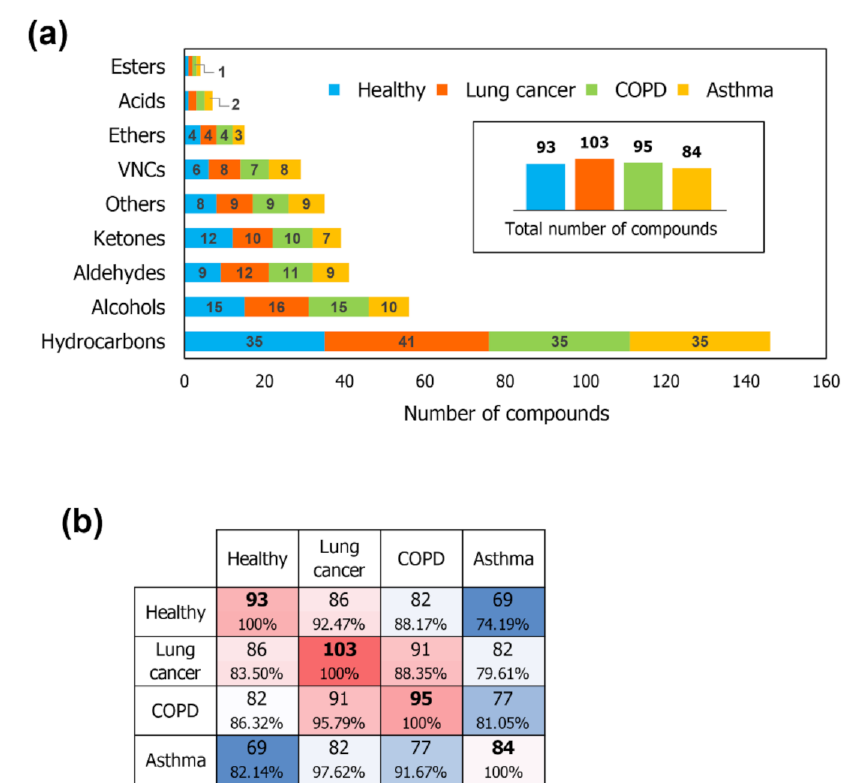
Figure 1. ( a ) VOCs distribution according to main chemical classes, in profiles belonging to the different studied groups, the contoured box displays the total number of compounds found in each group; ( b ) Similarity matrix displaying number and percentage of overlapping VOCs in the acquired